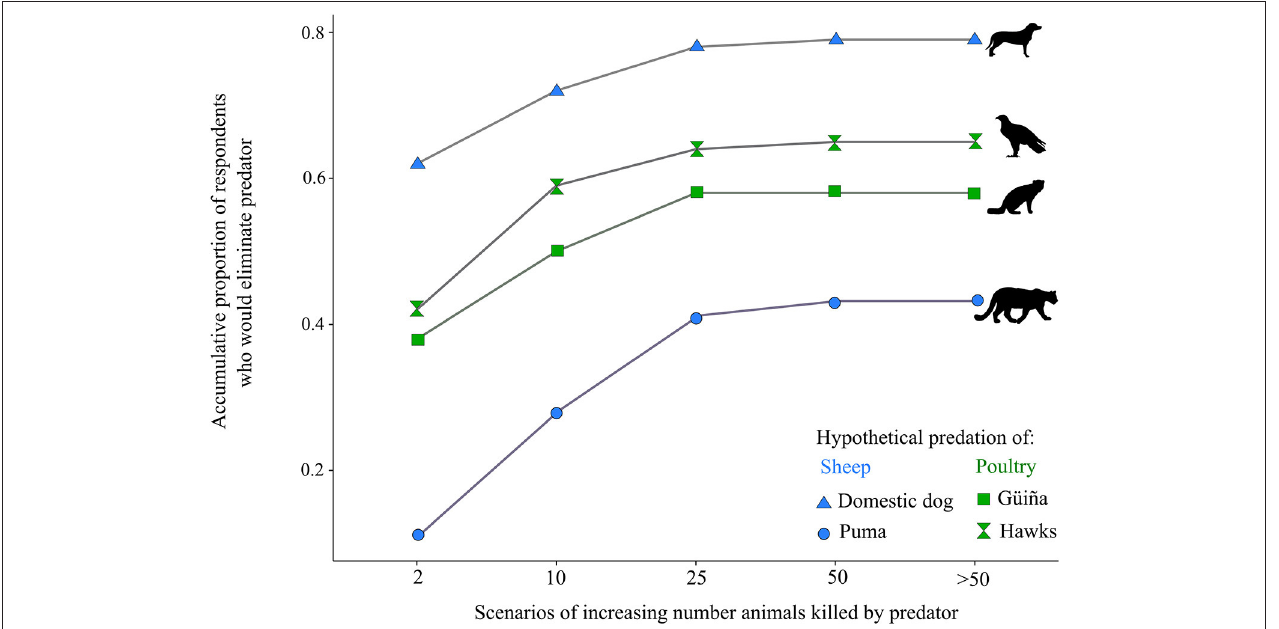
FIGURE 3 | Tolerance to livestock predation as the proportion of questionnaire respondents ( N = 233) reporting that they would kill a specific predator in response to an increasing quantity of hypothetical livestock killed. The baseline for each scenario was that a farmer had a total of 100 sheep or chickens and experienced losses of 2, 10, 25, 50 and > 50 individuals as a consequence of predation. The puma and domestic dog are sheep predators, whereas hawks and güiña are the poultry predators.